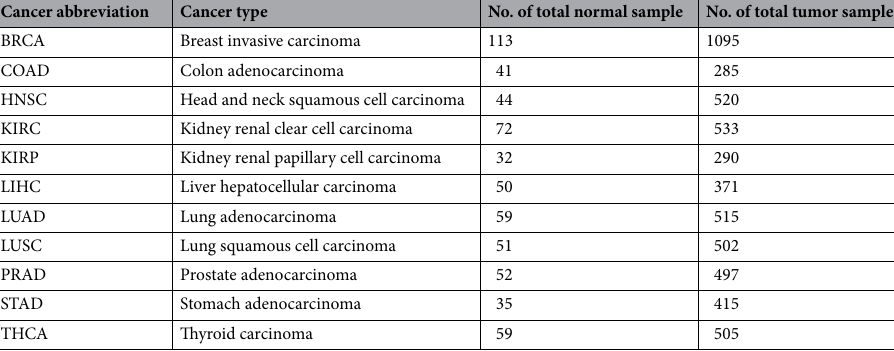
Table 1. Expression datasets of RNA-seq and clinical data in 11